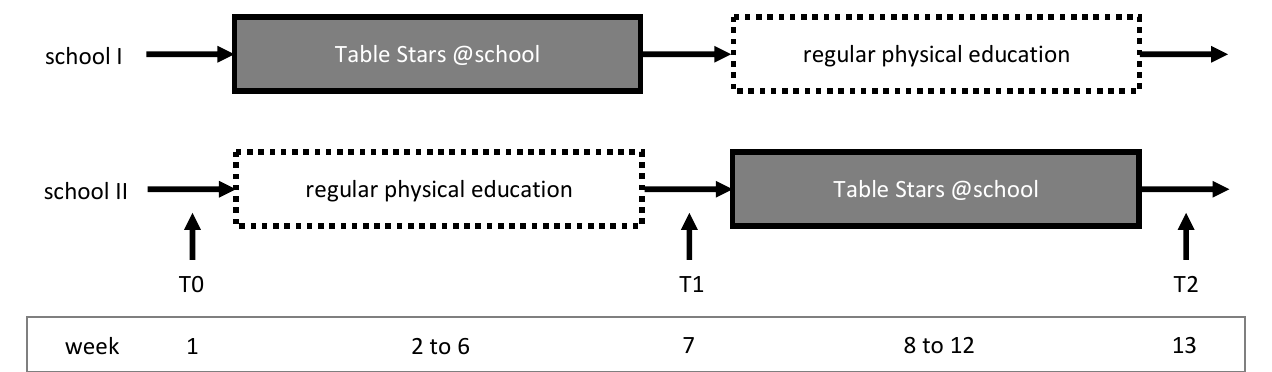
Figure 1 . Study design